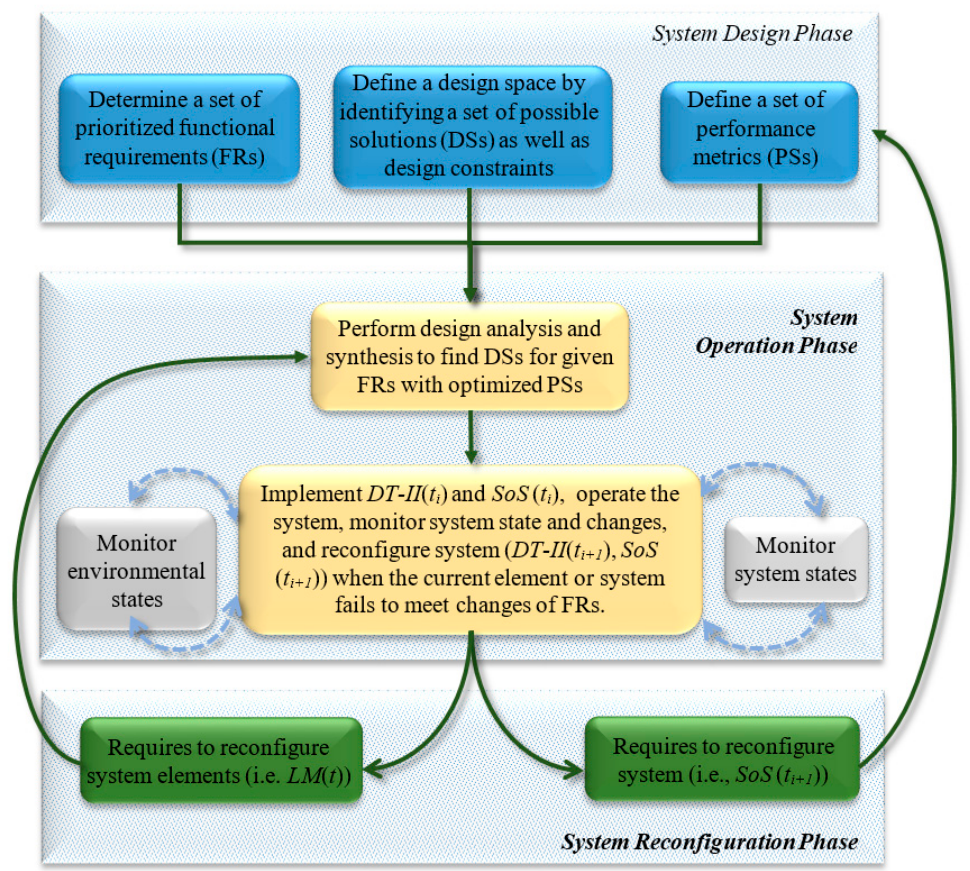
Figure 1. Three phases in design of a smart manufacturing system .